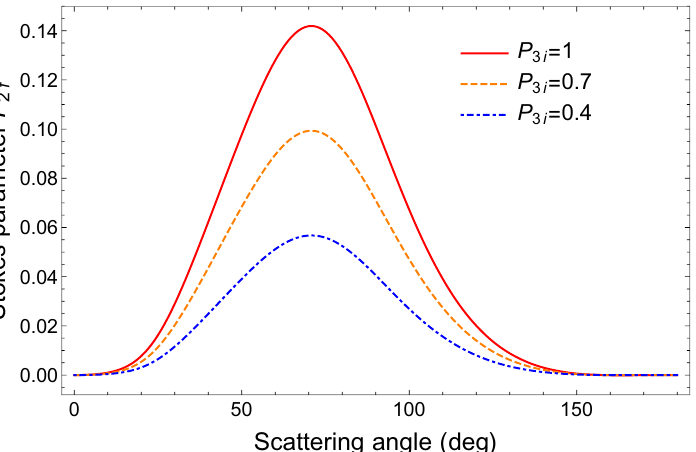
Figure 3. The second Stokes parameter P 2 f of the outgoing photons for the Rayleigh scattering of circularly polarized 500 keV photons by a lead atom. Calculations were performed for different degrees of circular polarization of the incident light: P 3 i = 1 (red solid line), P 3 i = 0.7 (orange dashed line), P 3 i = 0.4 (blue dash-dotted